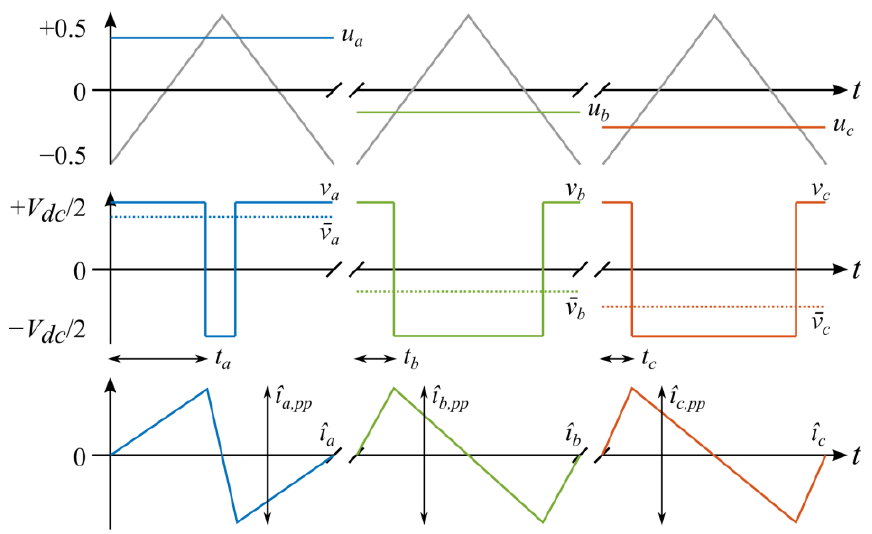
Figure 2. Carrier and modulating signals ( top ), inverter phase voltages with averaged values ( middle ), and phase current ripple and peak-to-peak ˆ i x , pp definition ( bottom ) over the switching period T sw .